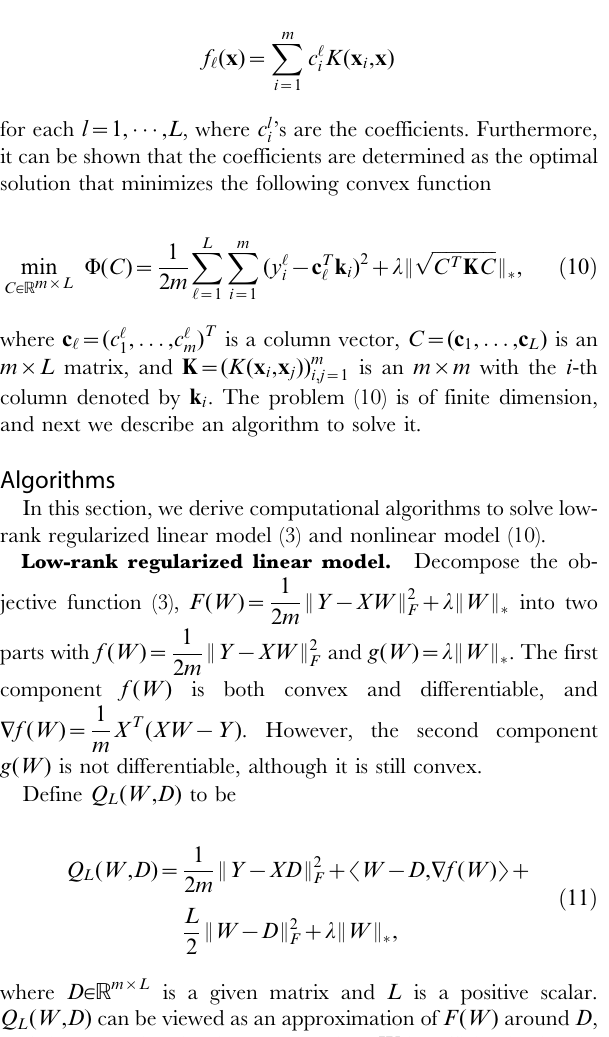
Algorithm 1. Nesterov’s algorithm for solving (3)